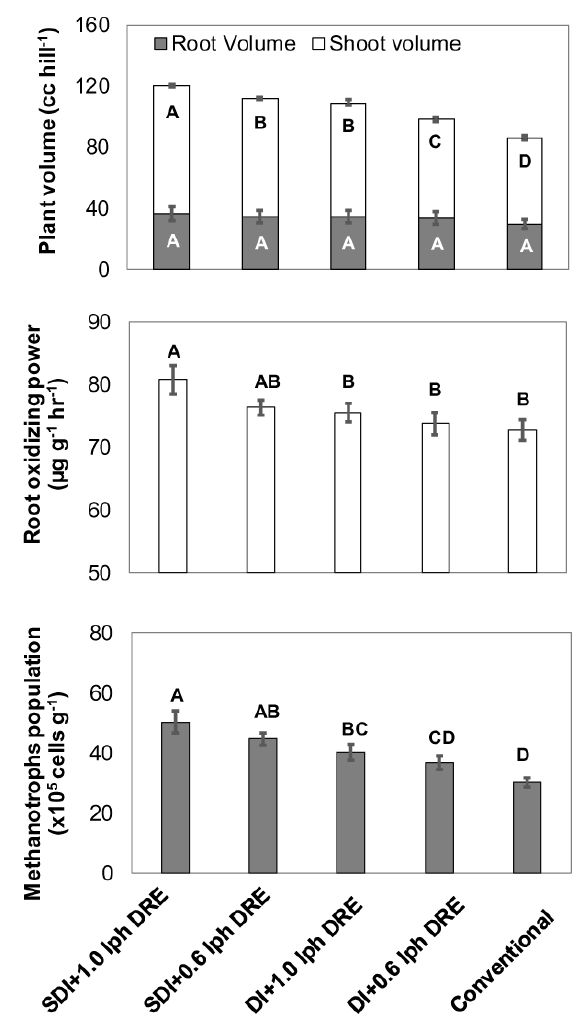
Figure 4. Effect of drip irrigation treatments on change in plant volume (root+shoot), root oxidizing power and soil methanotrophs population. Error bars indicate standard error of the mean (n = 6). Different letters denote significant differences among means derived using an ANOVA and student test. SDI, sub-surface drip irrigation; DI, surface drip irrigation; DRE, discharge rate emitters; Conventional, conventional flood aerobic irrigation.